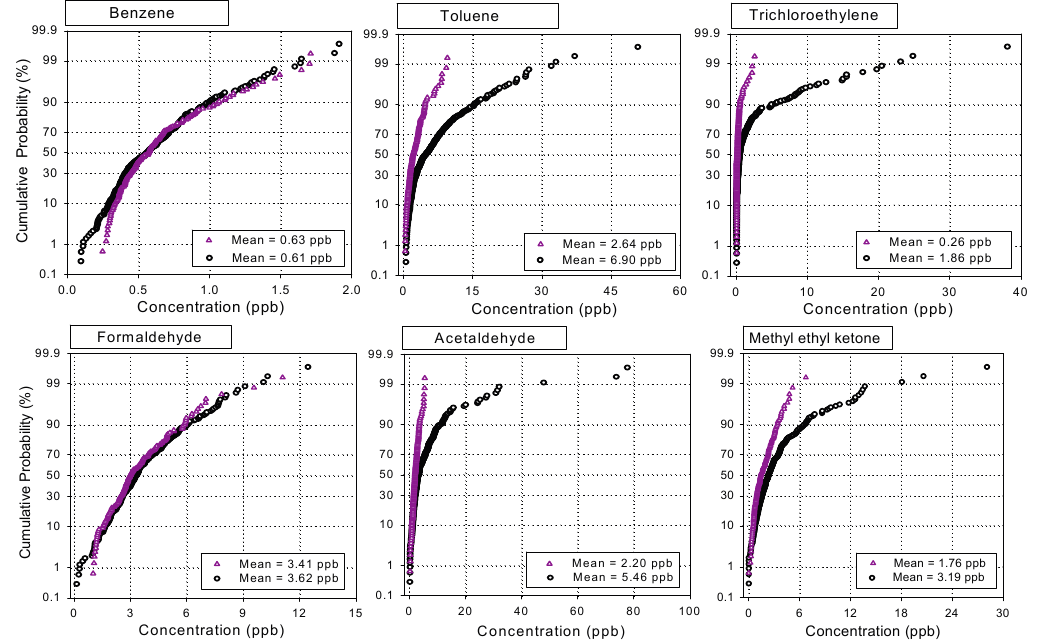
Figure 2. Comparison of the concentration distributions of selected VOCs in industrial (circle dot) and non-industrial areas (triangle dot) for the first campaign during 2003/2004.